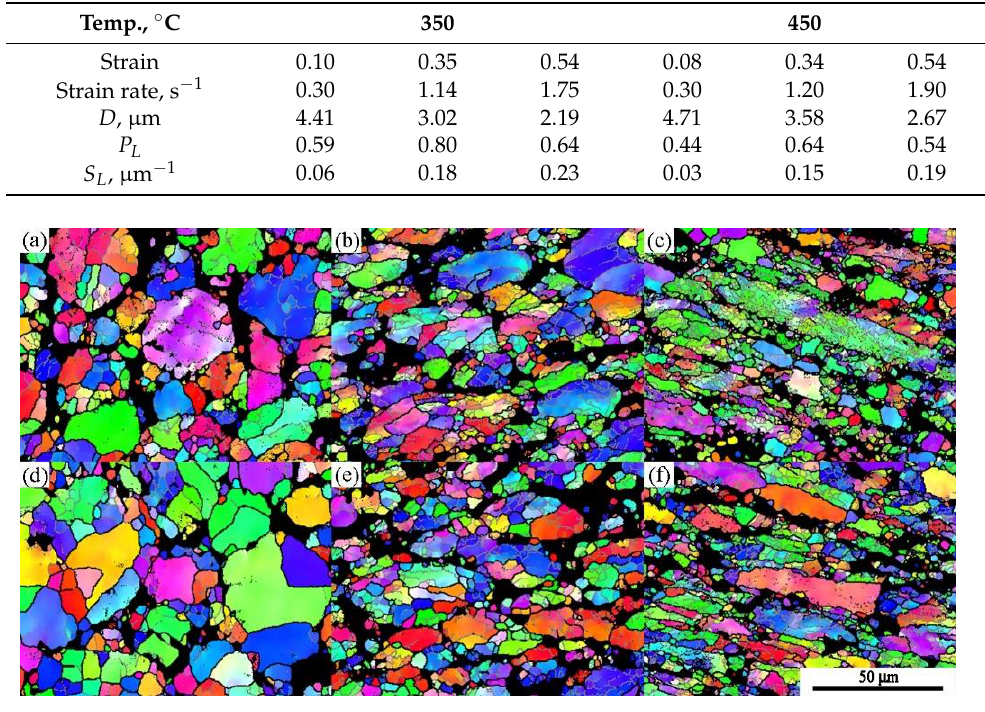
Figure 12. EBSD images of the composite matrix microstructure at deformation temperatures ( a – c ) of 350 °C ( d – f ) and 450 °C, which correspond to the following strain and strain rate conditions: ( a ) ε = 0.10 and 0.30 s − 1 ; ( b ) ε = 0.35 and 1.14 s − 1 ; ( c ) ε = 0.54 and 1.75 s − 1 ; ( d ) ε = 0.08 and 0.30 s − 1 ; ( e ) ε = 0.34 and 1.20 s − 1 ; ( f ) ε = 0.54 and 1.90 s − 1